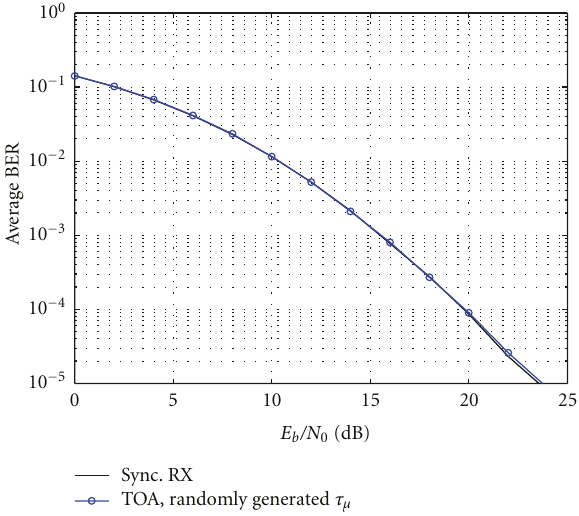
Figure 10: Average BER of quasi-synchronous BS-CDMA with two iteration of SIC for random uniformly distributed i.i.d.